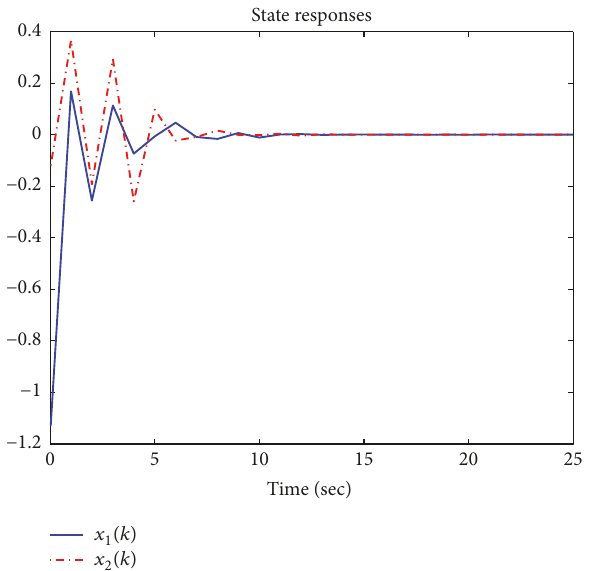
Figure 2: State trajectories of the closed-loop system in Example